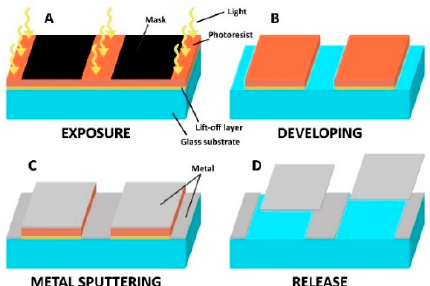
Figure 1. Lift-off photolithography. ( A ) A pattern is exposed on a photosensitive layer; ( B ) exposed (positive tone) photoresist as well as the sacrificial layer underneath are dissolved in the developer; ( C ) resulting 3D structures are covered by a layer of metal; ( D ) remaining resists are stripped by a suitable solvent releasing the metal layer on top.